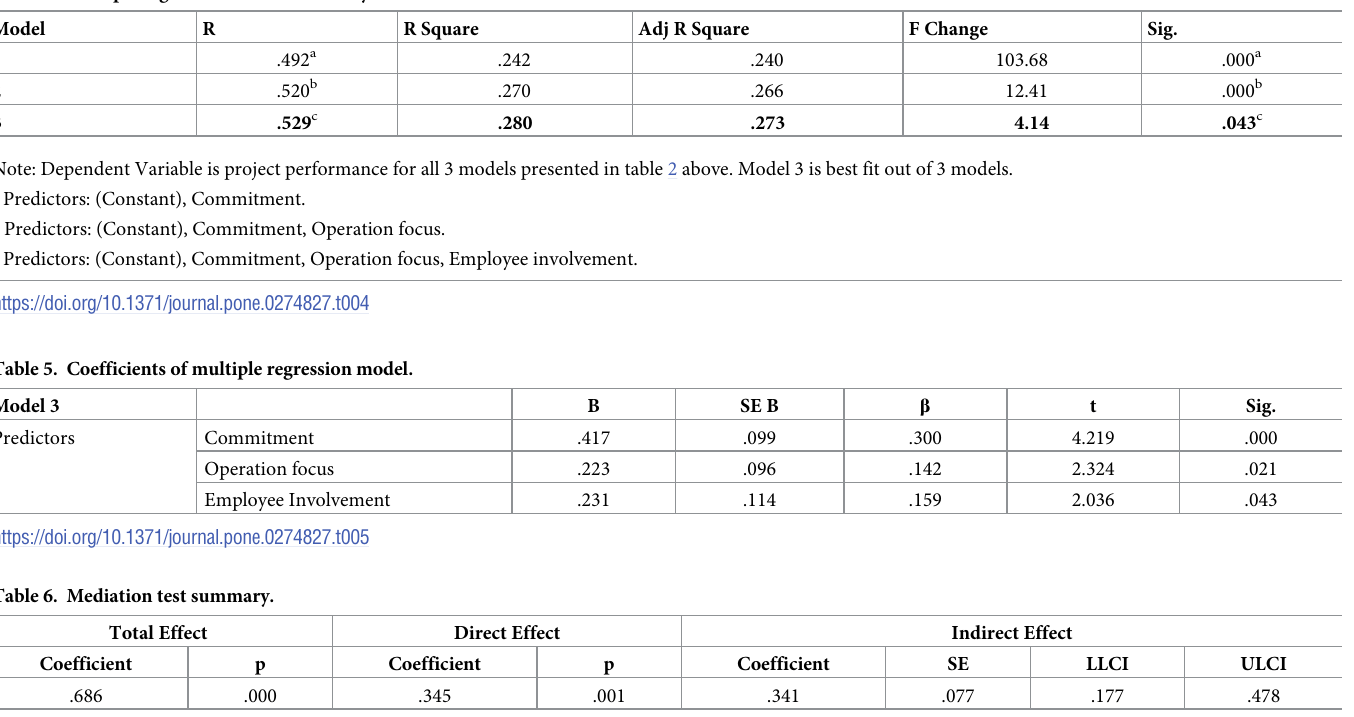
Table 4. Multiple regression results summary.